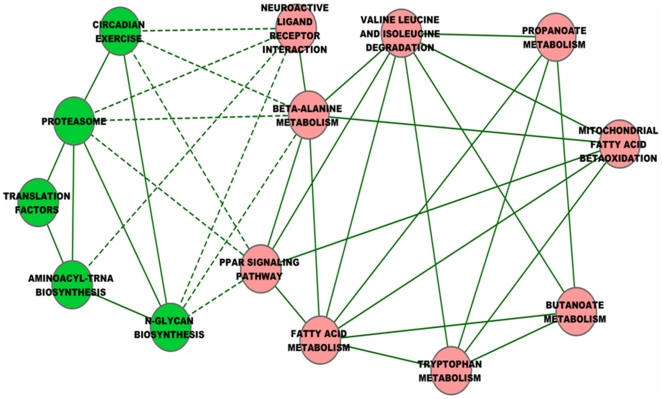
Network of hubs (Pathways with both high responsiveness and high connectivity).The network was constructed from Pearson correlation analysis using NES scores across 43 perturbations as meta-activities of molecular pathways. Pathways with Pearson correlation coefficient (PCC)>0.5 or PCC<−0.5 are considered connected to each others. Pink nodes (Group A) of hubs compose mostly lipid-related pathways and green nodes (Group B) of hubs are non-lipid pathways. Solid and dash lines indicate positive and negative correlations, respectively.